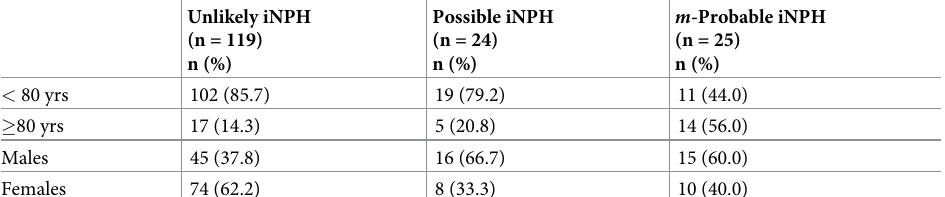
Table 2. The age and sex distribution of the study sample (n = 168), broken down into diagnosis (American-Euro- pean guidelines). Unlikely iNPH (n = 119) n